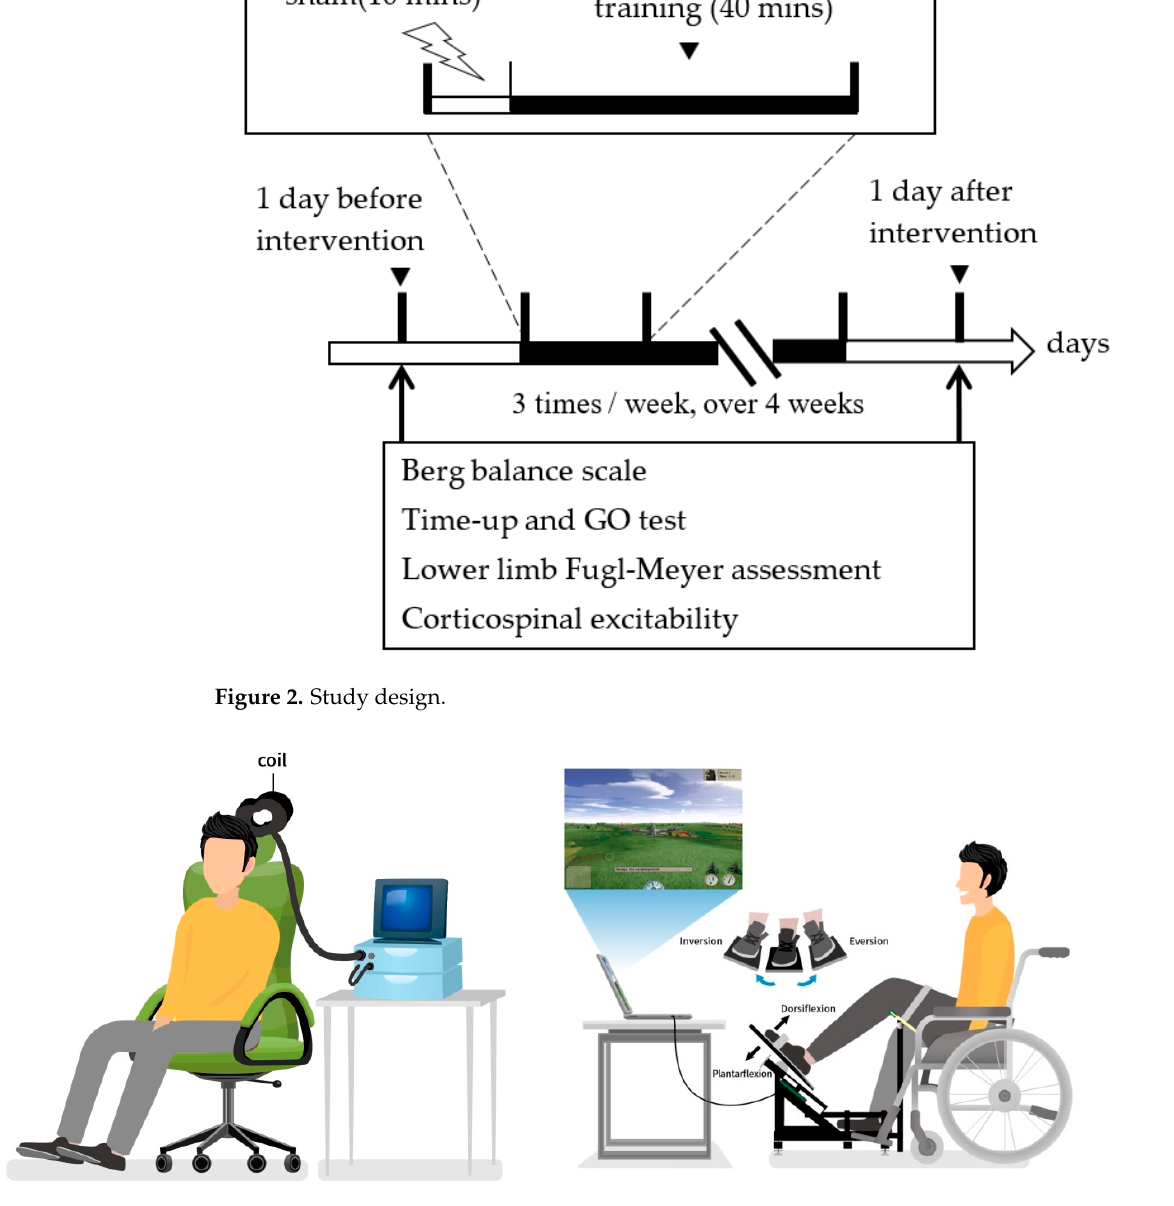
Figure 3. The rTMS and the VF training. ( A ) Application of 1-Hz, 110% resting motor threshold rTMS or sham rTMS before visual feedback training or conventional rehabilitation. ( B ) Architec- ture of game-based visual feedback intervention system; movement at the extent of the paretic an- kle’s range in the sagittal (plantarflexion/dorsiflexion) and frontal (eversion/inversion) planes used to move an aircraft displayed in real-time on an LCD monitor to provide direct visual feedback.